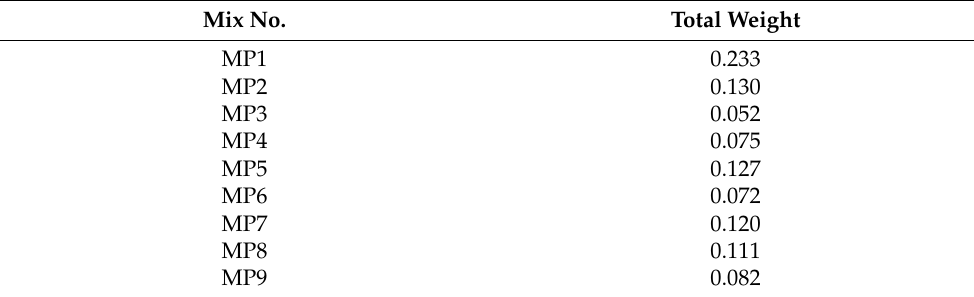
Table 10. Total weight of each experimental run.